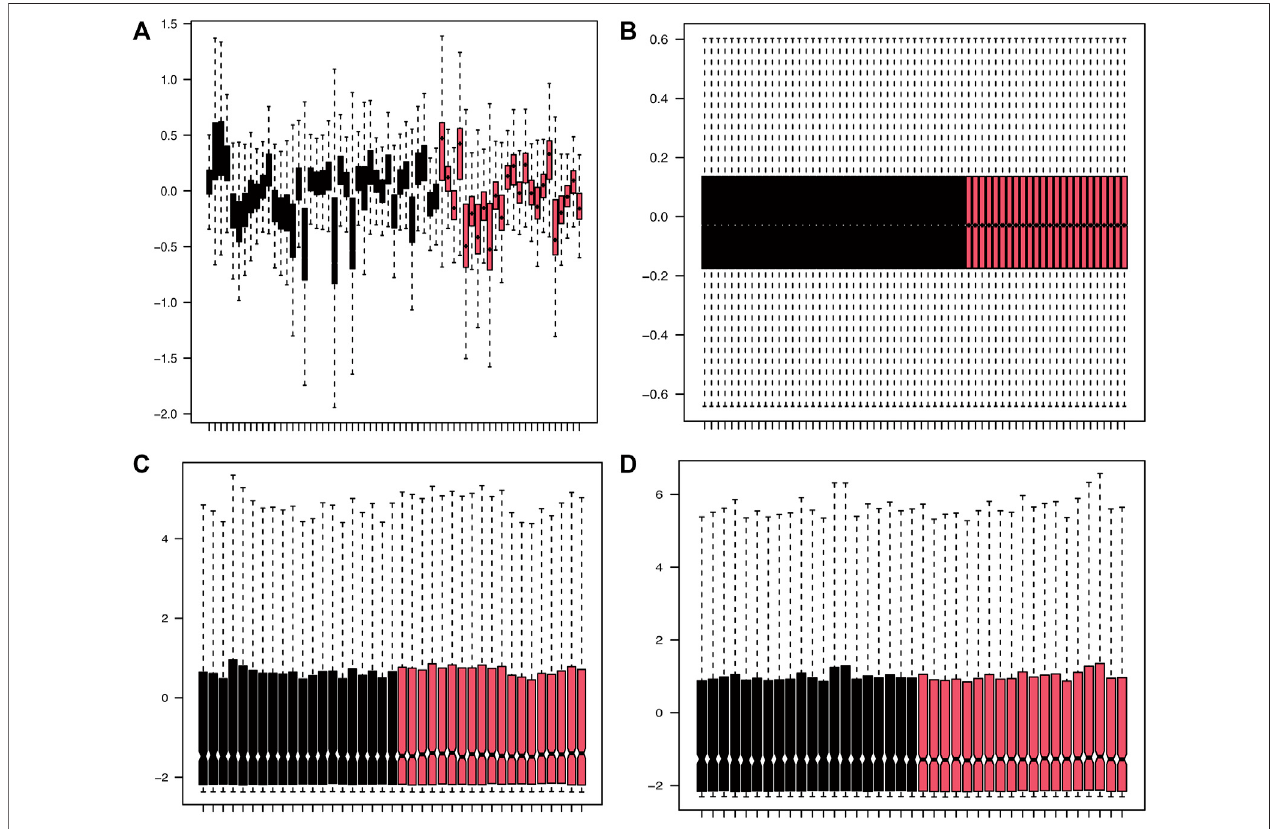
FIGURE 2 | Density plots of the dataset samples before and after correction. (A,B) The boxplot of GSE16561 dataset samples before and after correction after removing the inter-batch differences. (C,D) The boxplot of GSE110993 dataset samples before and after correction after removing the inter-batch differences.